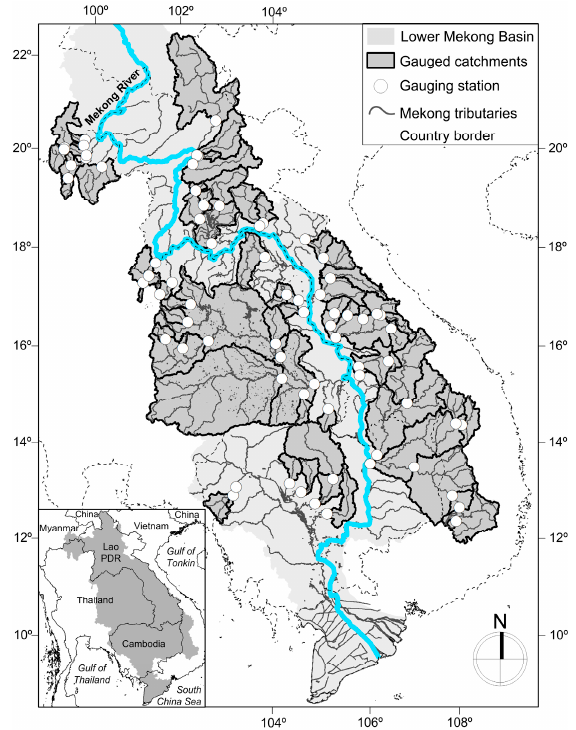
Figure 3. Gauged sub-catchments of the Lower Mekong Basin.